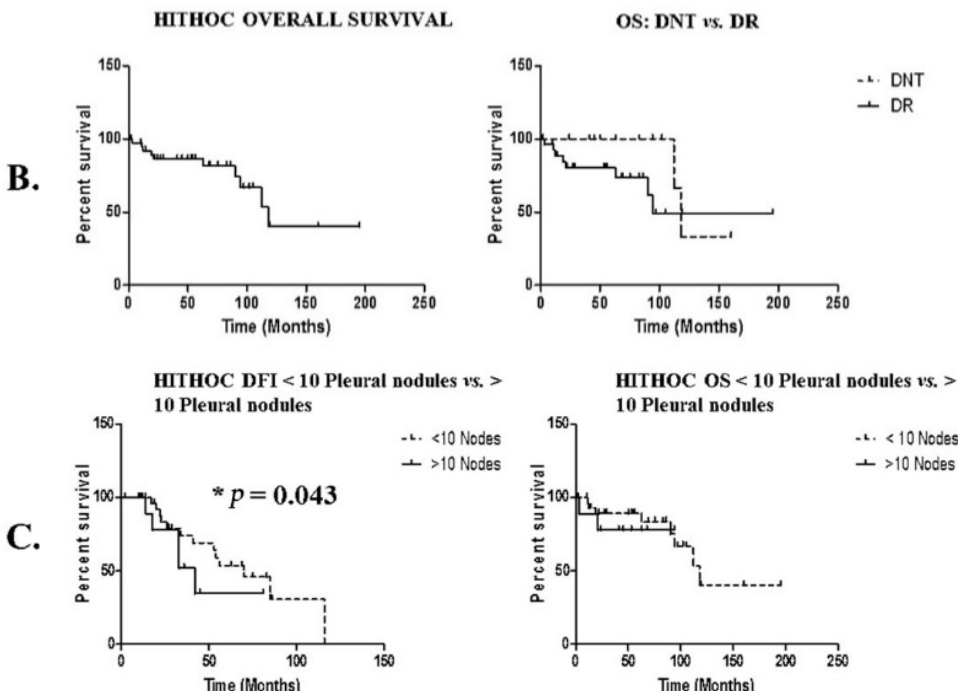
Figure 2. Disease-free interval (DFI) and overall survival (OS) overview. ( A ) Analysis of disease-free interval (DFI) of the entire cohort, comparing IVa de novo vs. distant relapse. ( B ) Analysis of overall survival (OS). ( C ) Analysis of DFI and OS in <10 or >10 resected pleural nodule groups.